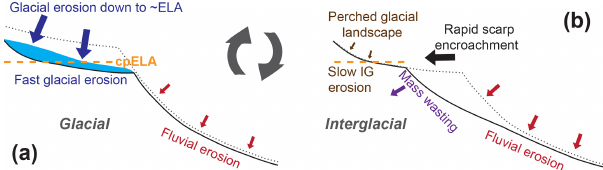
Figure 14. Schematic of glaciofluvial limitation. (a) ELA acts as a perched base level. Glacial erosion expands terrain near the ELA. Glacial erosion slows to zero at the front of the ablation zone, and blocks fluvial incision. Below glacier terminus, fluvial incision con- tinues. (b) Escarpments below glaciated landscapes drive headward and remove glaciated terrain during interglacial (IG)